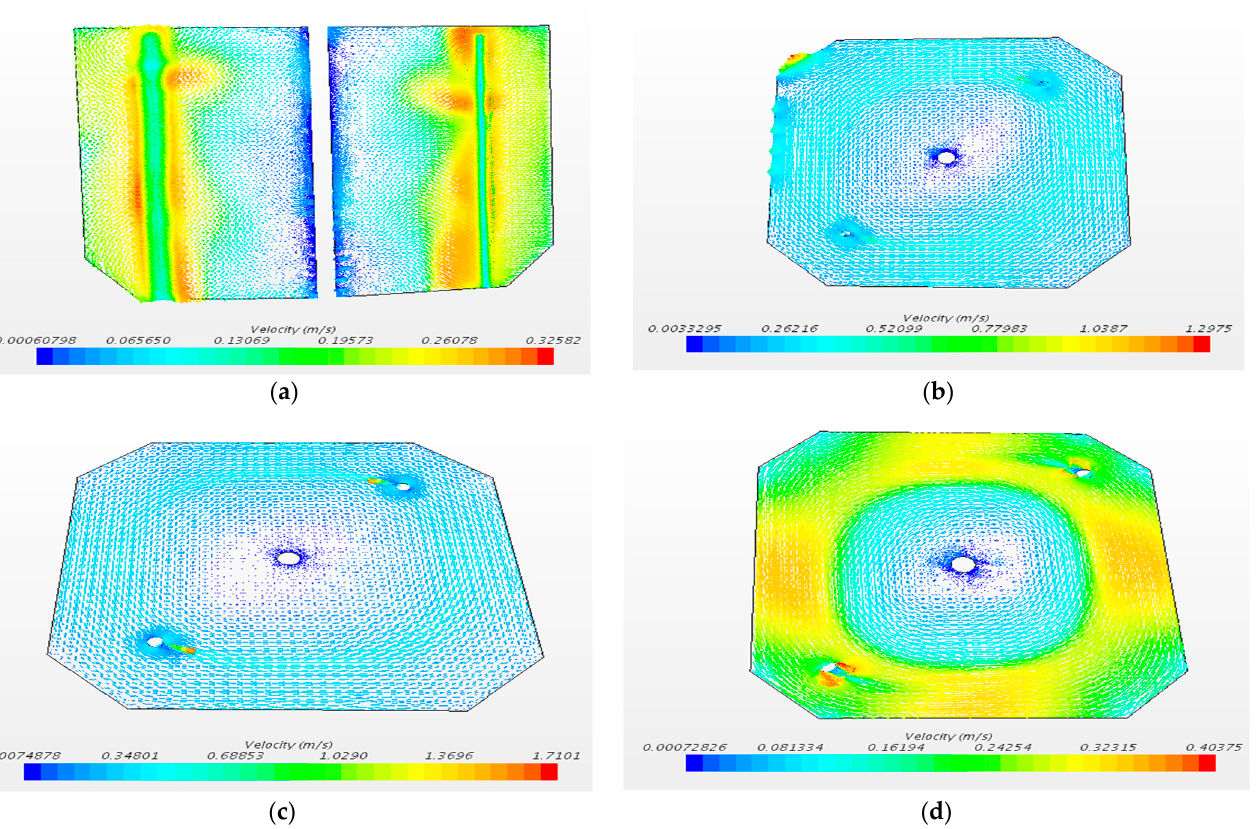
Figure 12. ( a ) middle longitudinal section, ( b ) H = 16.5 m cross section, ( c ) H = 8.5 m cross section, ( d ) H = 1.5 m cross section.